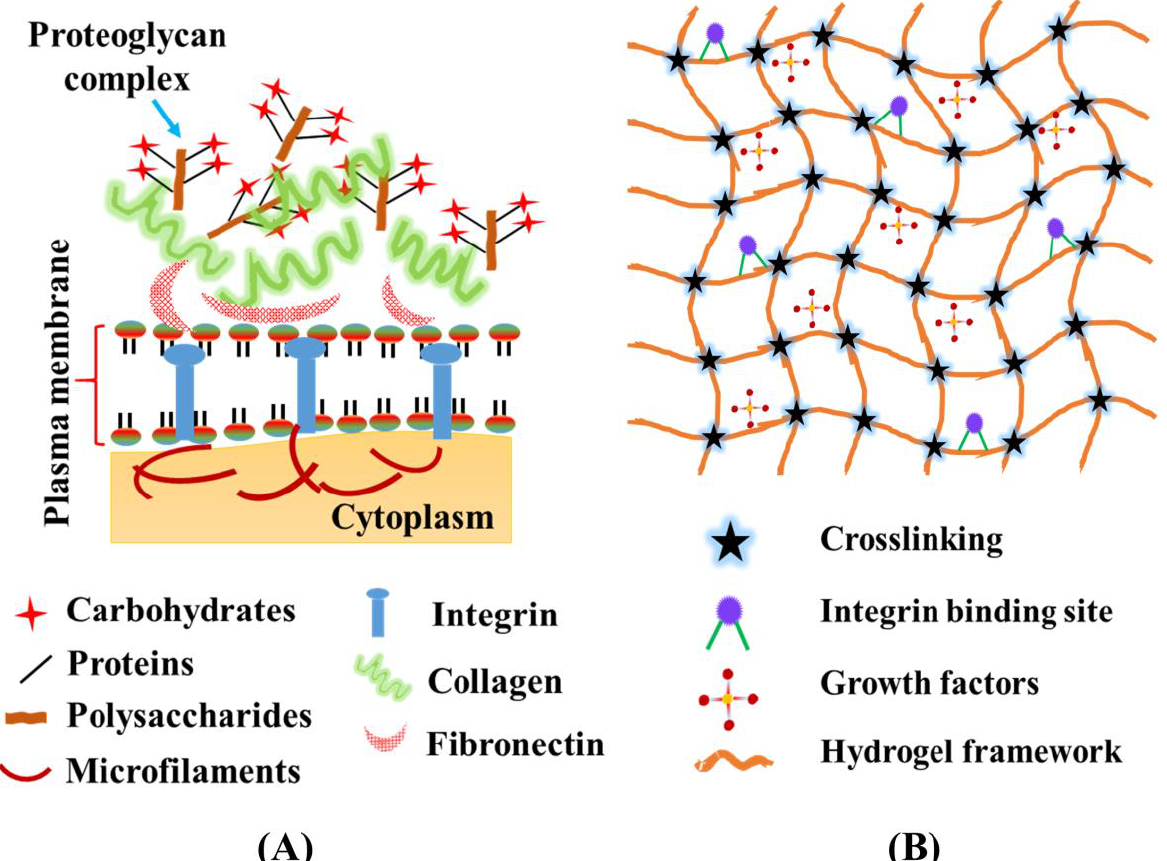
Figure 5. ( A ) Components of extra cellular matrix (ECM); ( B ) structural framework of hydrogels imitating the biophysical and functional prospective of ECM.